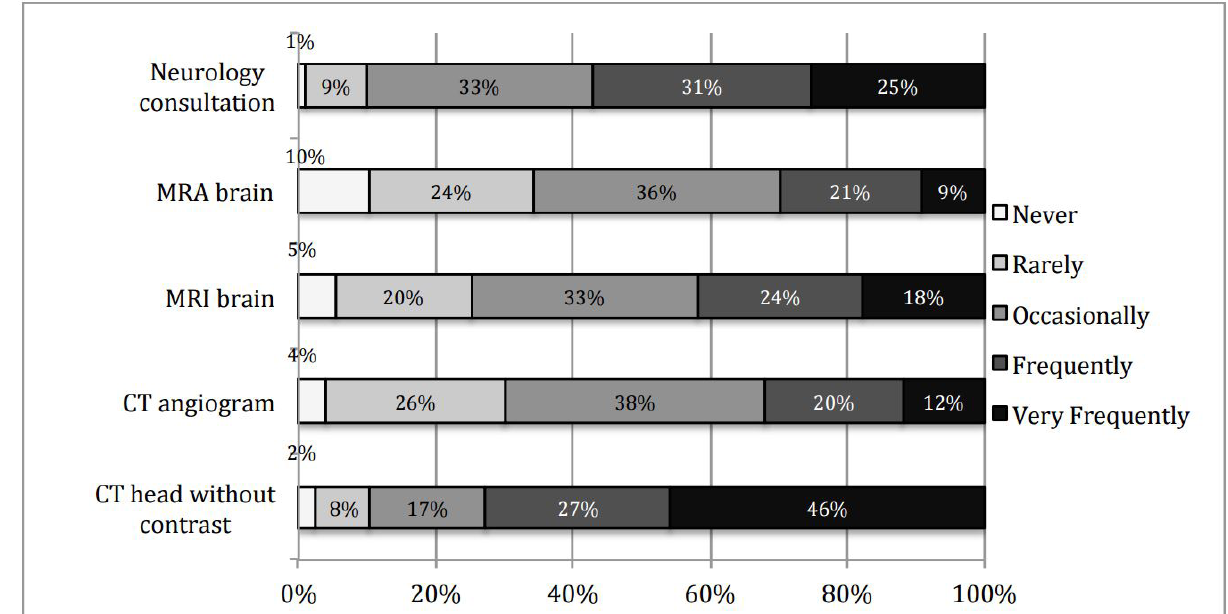
Figure 1. Current use of consultation and neuroimaging to evaluate dizziness in the emergency department a . a Survey question 5: percentages indicate percent of respondents choosing a given answer.